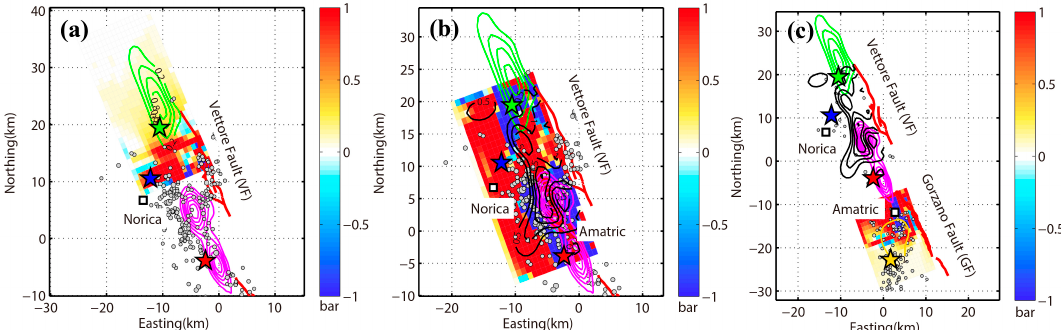
Figure 10. ( a ) Coseismic Coulomb stress change on the fault plane of the 26 October 2016 event triggered by the 24 August 2016 event; green contour lines: the 26 October 2016 event coseismic slip contours every 0.2 m; magenta contour shows the 24 August 2016 event rupture area; gray dots denote the aftershocks of ML > 3 from 24 August to 25 October 2016 [12]. ( b ) Stress change induced on the 30 October 2016 event triggered by 24 August and 26 October 2016 events; black contour lines show the 30 October 2016 event coseismic slip contours every 0.5 m; green and magenta contour show the 26 October and the 24 August 2016 events rupture area, respectively; gray dots denote the aftershocks of ML > 3 from 26 October 2016 to 17 January 2017 [12]. ( c ) Stress change induced on the fault of the 2017 event triggered by the first three events; golden yellow contour lines show the 18 January 2017 event coseismic slip contours every 0.2 m; magenta, green, and black contours show the 24 August, 26 October, and 30 October 2016 events rupture area, respectively; gray dots denote the aftershocks of ML > 3 from 18 January to 30 June 2017 [12].